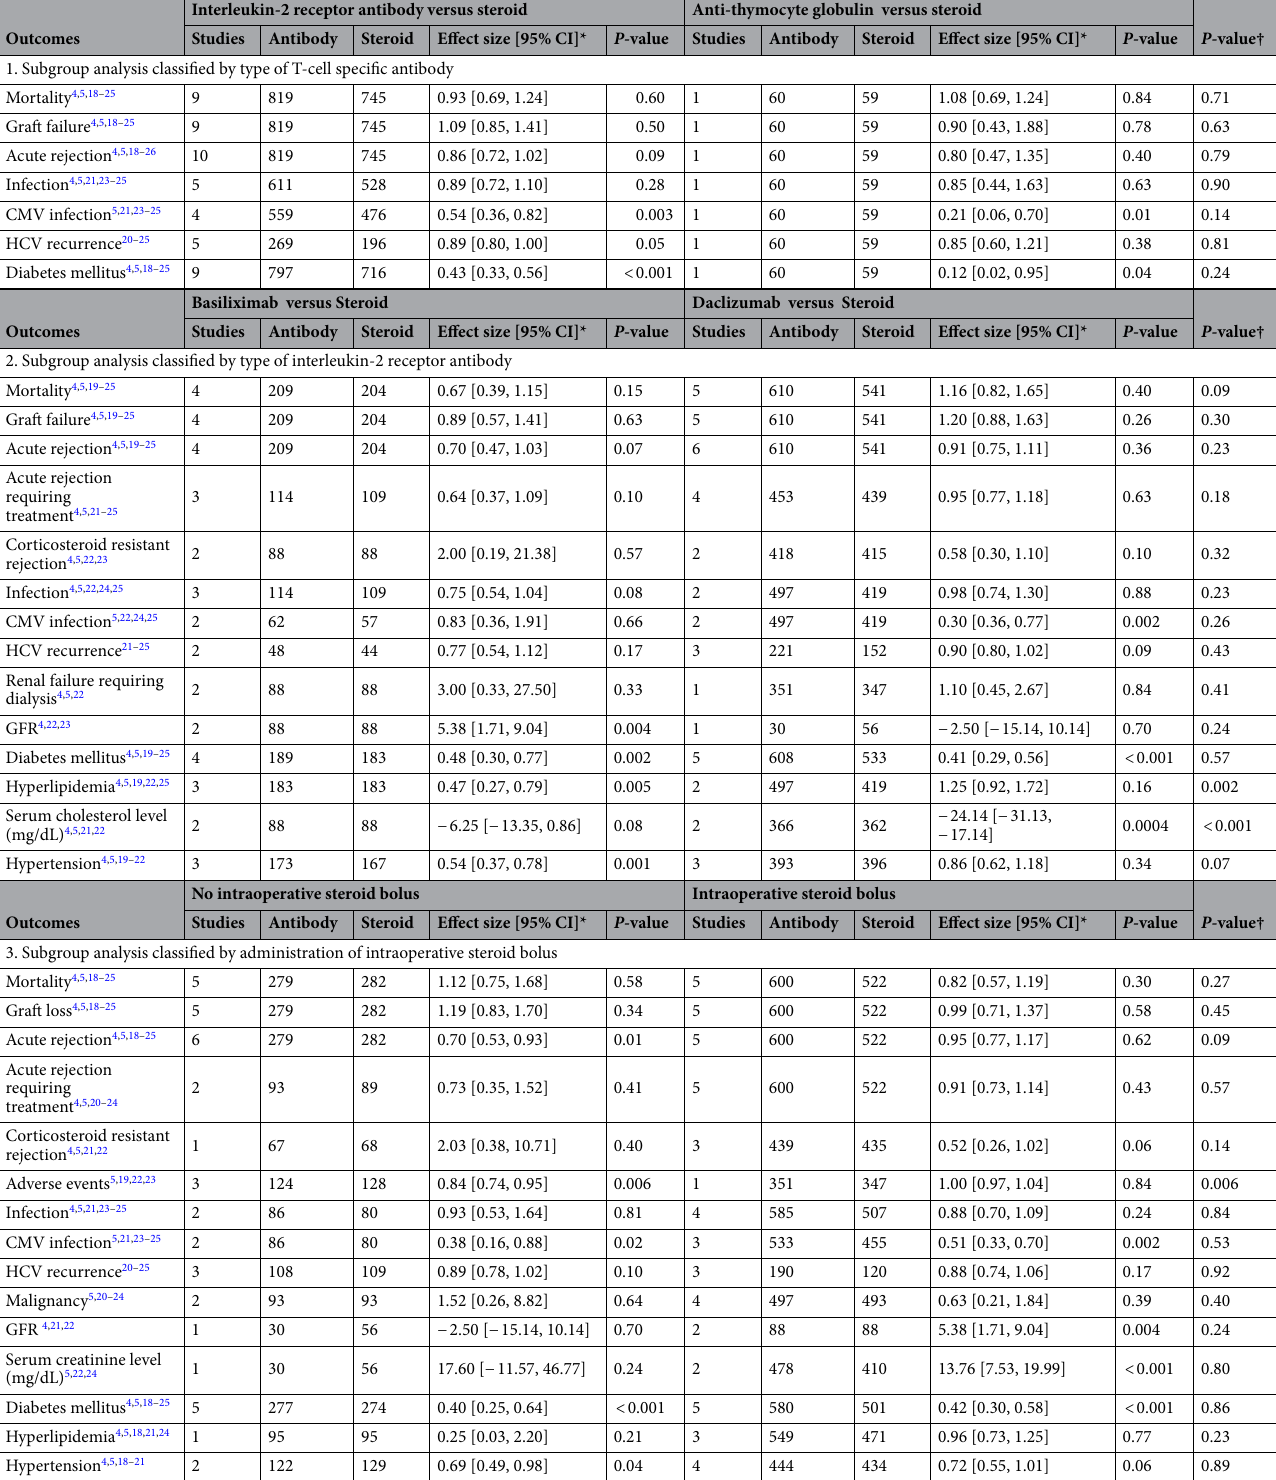
Table 3. Results of subgroup analyses. *The data are presented as mean difference or risk ratio with its 95% confidence interval (CI). † P -value for interaction. CMV, cytomegalovirus; HCV , hepatitis C virus; GFR, glomerular filtration